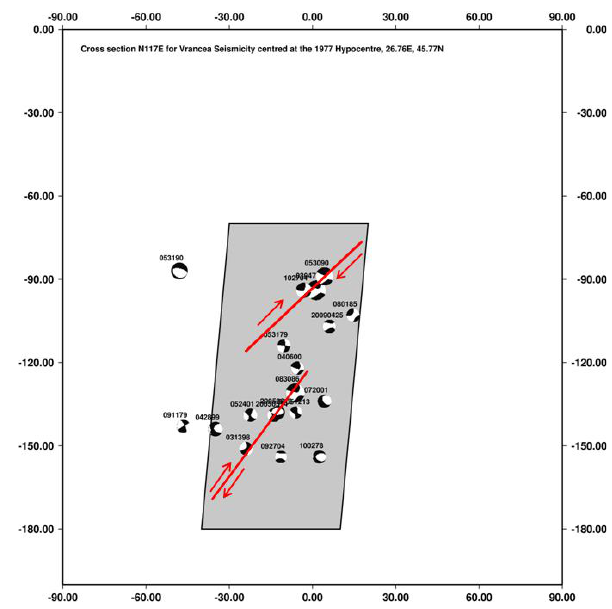
Fig. 9. Cross-section of intermediate-depth seismicity reported at Table 8, oriented ESE-WNW. Beach balls represent the frontal pro- jections of the available fault plane solutions of Fig. 8, in order to indicate the kinematics of the deformation. The date of each event is written above each sphere. Shaded rectangle shows the possi- ble extent of the dipping slab. Red lines indicate location of major faults. Table 8. List of intermediate depth events with M > 4 . 8 for the period 1976–2010 (source Global CMT Catalog, http://www. globalcmt.org). ∗∗ indicates depth after Oncescu and Bon- jer, 1997. ∗ indicates optimal orientation to compression axis (N307 ◦ E–N323 ◦ E, ± 10 ◦ ). 10 out of 19events are included in that range. Strike/Dip/Rake angles are in